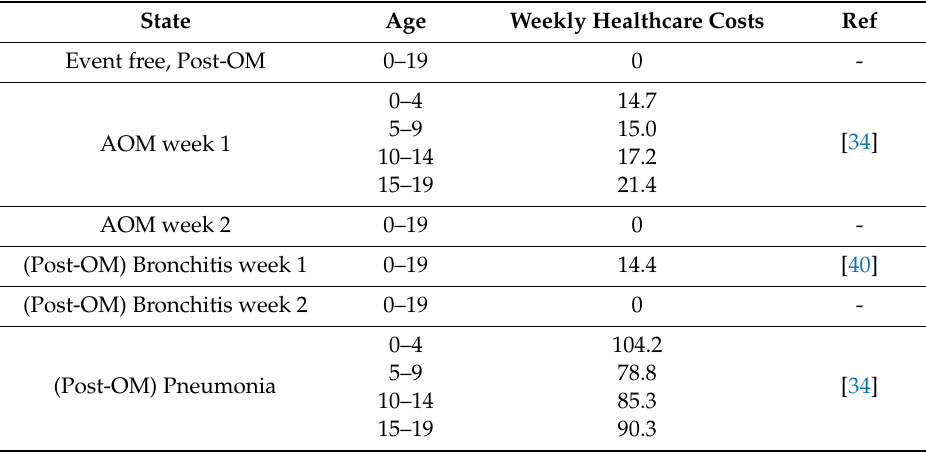
Table 3. SHS-related weekly morbidity costs in 2018 US dollars used in the